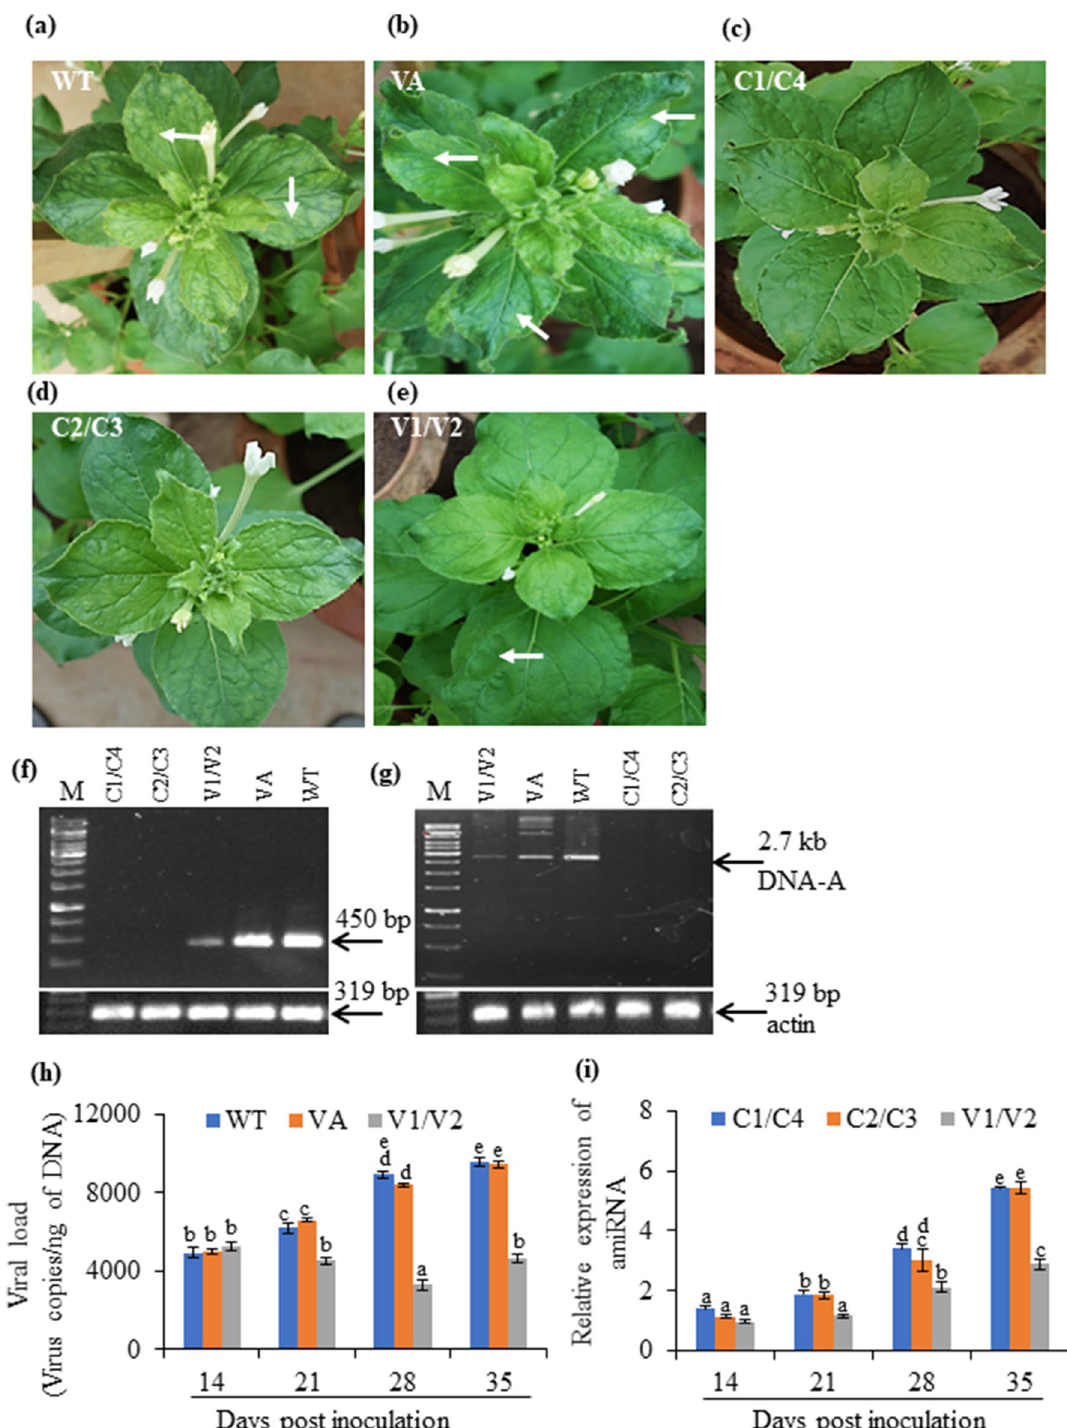
Figure 2. Characterization of the N. benthamiana transgenics overexpressing the amiRNA against C1/C4, C2/C3 and V1/V2 ORFs, respectively. Representative pictures to show viral symptoms in ( a ) WT, ( b ) VA, ( c ) C1/C4, ( d ) C2/C3 and ( e ) V1/V2 amiRNA transgenics after 28 dpi. Arrow indicates yellow mosaic/ leaf distortion symptoms. ( f ) PCR amplification of genomic DNA (upper panel) and actin gene as a control (lower panel) in agroinfiltrated WT, VA and transgenics for detection of JLCuGV in infected samples (at 28 dpi). ( g ) Hind III digested RCA products of the agroinfiltrated C1/C4, C2/C3, V1/V2 transgenics, WT and VA for detection of JLCuGV in infected samples (at 28 dpi). ( h ) The qRT-PCR based estimation of viral load in the infiltrated plants of WT, VA and V1/V2 transgenics after 14, 21, 28 and 35 dpi. ( i ) Relative expression of amiRNA in transgenics. Values are represented as means ± SD (n = 3) and marked with different alphabets (from ‘ a ’ to ‘ e ’) to indicate a significant difference as determined by Tukey test at P ≤ 0.05